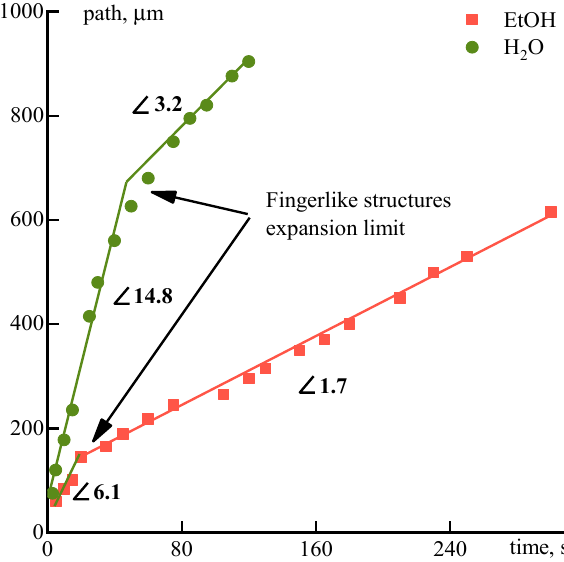
Figure 15. Micrographs of the selected coagulation stages of PANI-O solutions by ethanol and water. ( A ) growth of vacuoles, ( B ) di ff usion coagulation.